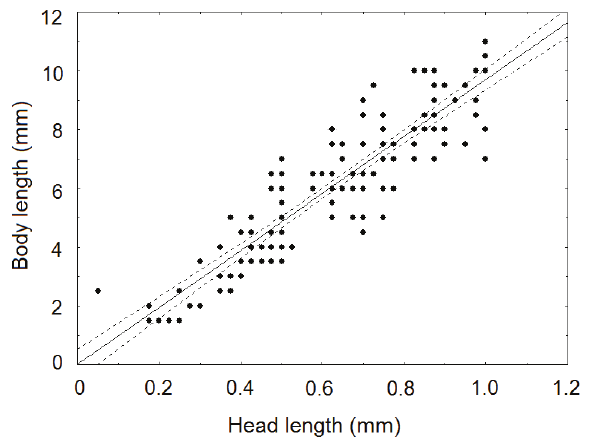
Figure 5. Regression line showing the positive relationship between the body length (BL) and the head length (HL) in 139 specimens (66 females, 61 males and 12 undefined sex) of Quadrivisio lutzi , where BL is close to ten times